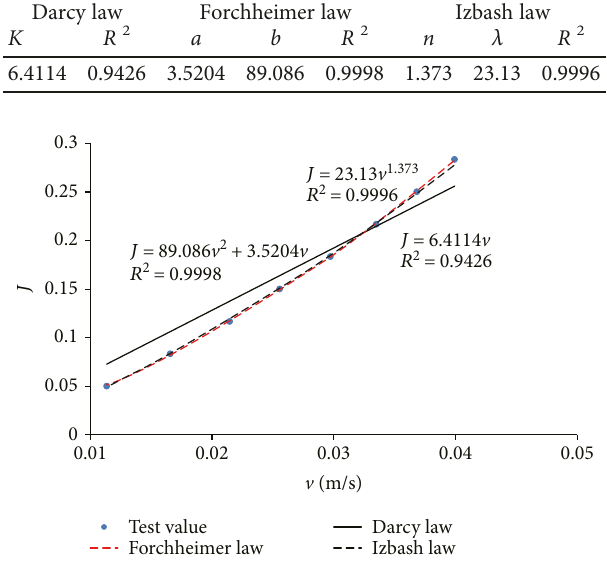
Figure 3: The relationship between the fl ow velocity and the hydraulic gradient.